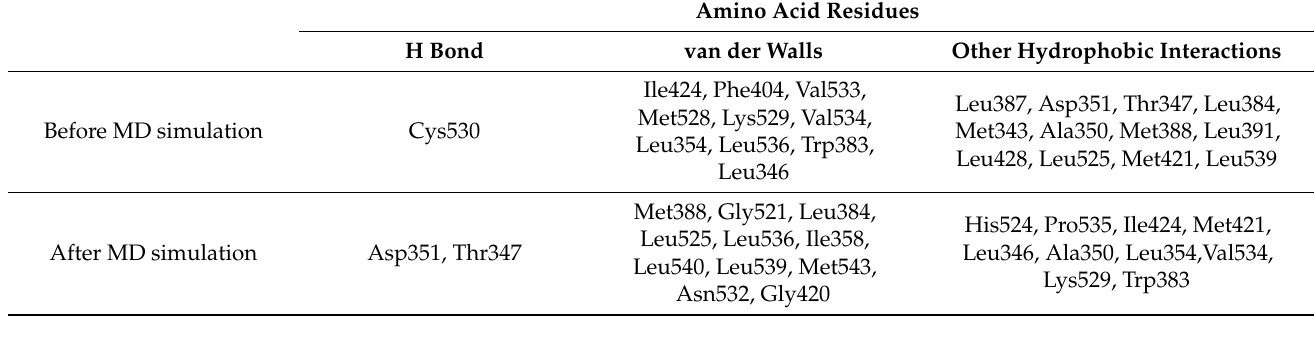
Table 3. Comparison of interactions of the title compound with amino acid residues before and after MD simulation.